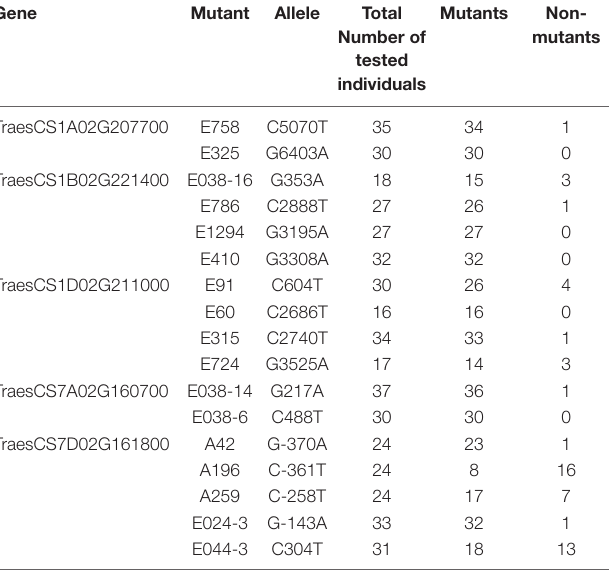
TABLE 4 | Validation of SNPs in M3 generation.